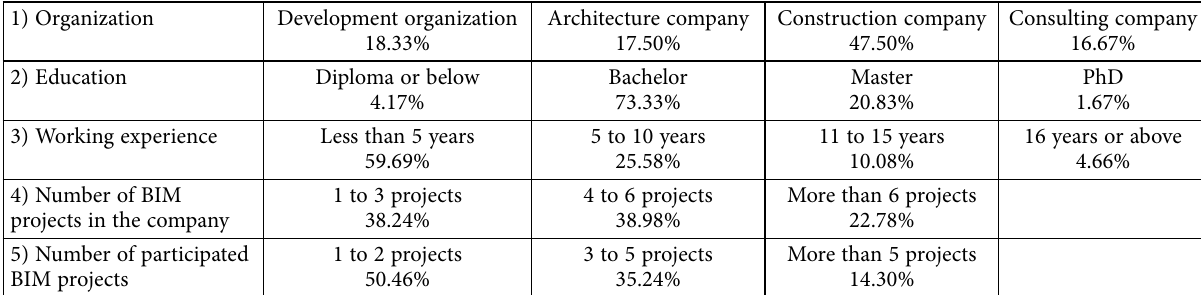
Table 6. Summary of descriptive background information of respondents ( N =